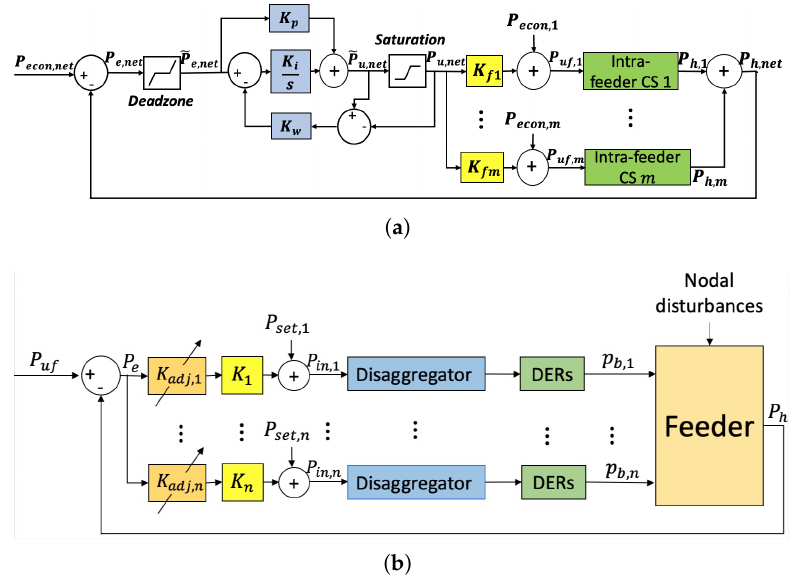
Figure 10. Hierarchical Real Time Control Scheme. ( a ) Inter-feeder Controller. ( b ) Intra-feeder